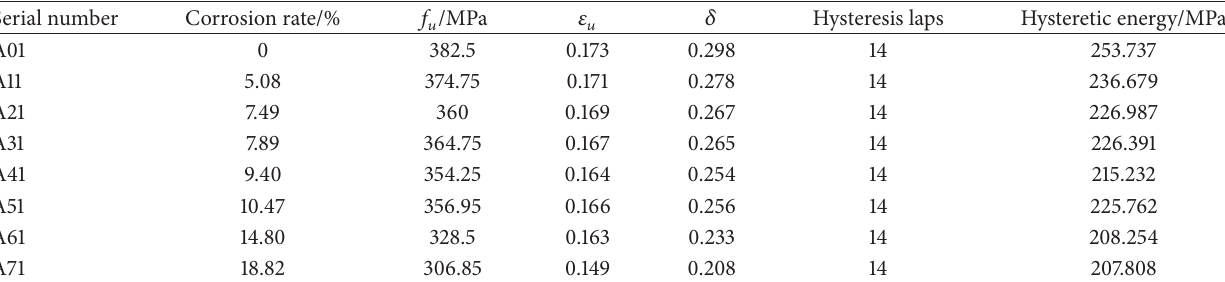
Table 1: Summary on mechanical properties of the specimen.